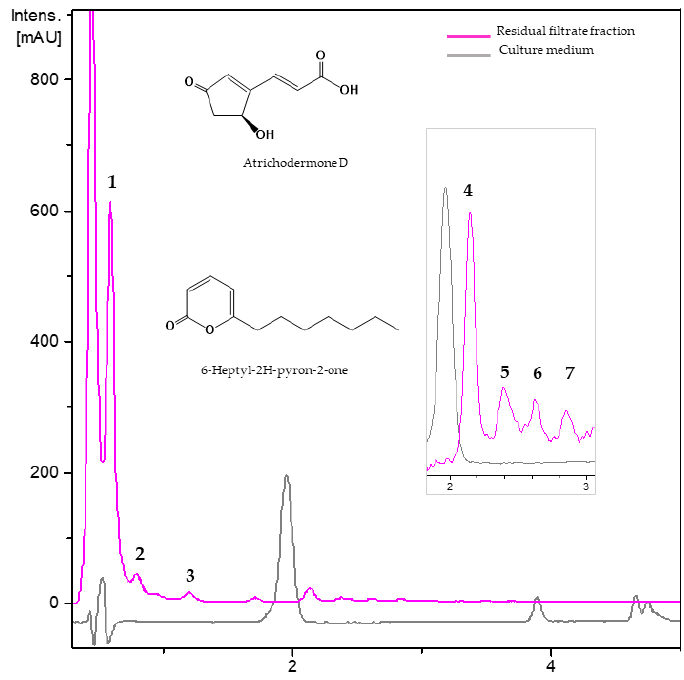
Figure 4. UV 210 nm chromatograms of residual filtrate fraction from Trichoderma ghanense Th26-52 and the unfermented culture medium. 1 : Not identified (C 11 H 16 O 7 ), 2 : not identified C 8 H 9 NO 3 , 3 : not identified C 8 H 10 O 3 , 4 : atrichodermone D, 5 : Not identified (C 11 H 12 O 5 ), 6 : not identified (C 14 H 18 O 3 ). 7 :